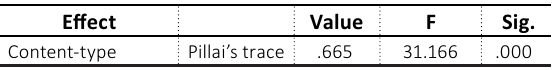
Table 5. Levene’s test. Table 6. Multivariate tests